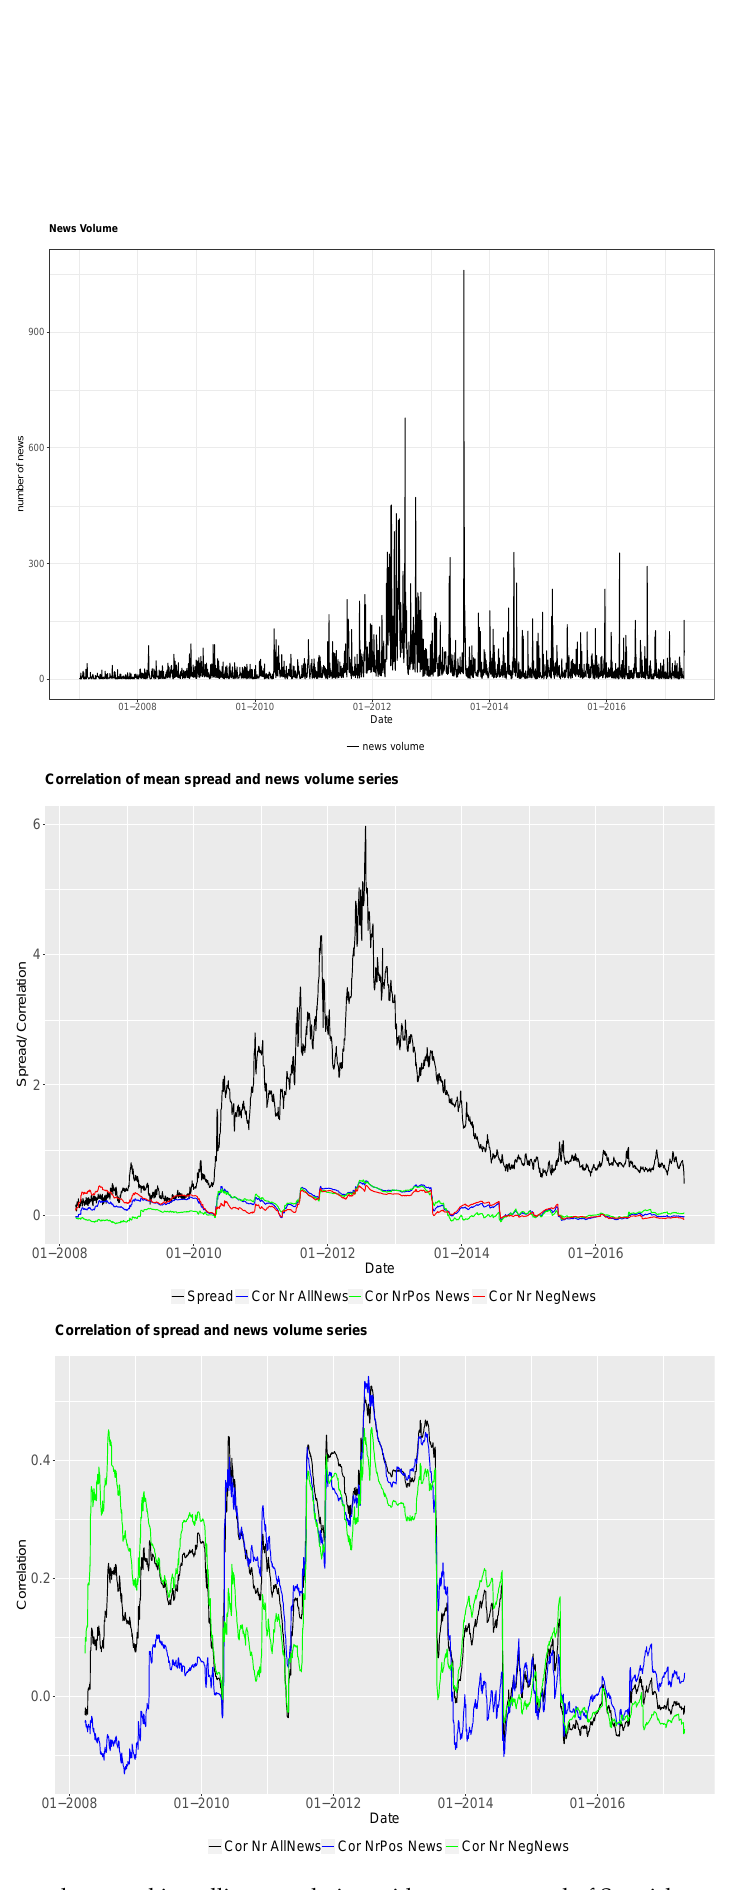
Figure 3. News volume and its rolling correlation with a mean spread of Spanish sovereign